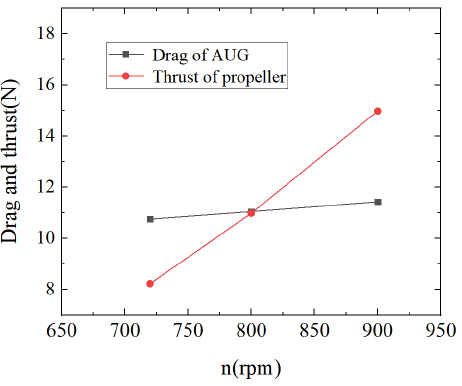
Figure 27. Self-propulsion results of the hybrid-driven AUG with the single propeller.